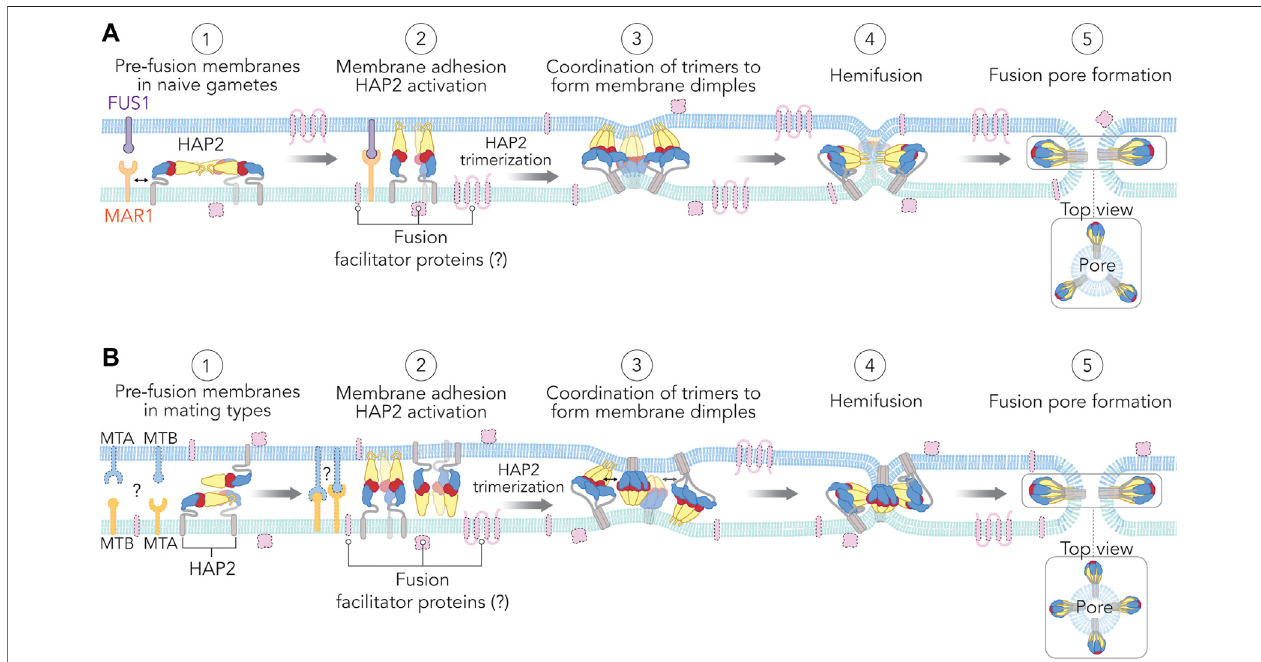
FIGURE 4 | Model molecular mechanisms for the (A) Chlamydomonas and (B) Tetrahymena gamete membrane fusion reactions. (1) Before fusion, HAP2 is expressed on the Chlamydomonas minus gamete mating structure, and membranes at the developing conjugation junction of Tetrahymena in an as yet unknown pre- fusion state. Both species strongly upregulate HAP2 expression after mixing of different mating types. The cytoplasmic domains of some proteins are not shown. Also, otherconservedorspecies-speci fi cfusionfacilitatorproteins(pink)thathavenotyetbeenidenti fi edmayactivelyparticipateinthisprocess. (2) In Chlamydomonas, FUS1-MAR1 mediated membrane adhesion activates HAP2 out of its pre-fusion state on naive minus gametes, driving HAP2 fusion loop interactions with the plus gametemembraneandtrimerformation.In Tetrahymena themembraneadhesionproteinsareunknown,butitispossiblethatMTAandMTBproteinsareinvolvedinthis recognition event, and similarly activate HAP2. (3) During conformational changes, the fusion loops and transmembrane domains of HAP2 proteins anchored in both membranes helps pull the two lipid bilayers close together. A circular coordination of several HAP2 trimers undergoing such changes is expected to form dimples in the apposed membranes. Chlamydomonas HAP2 trimers bridge the two membranes with their fusion loops anchored in the target plus gamete membrane, whereas Tetrahymena , having HAP2 protein expressed and functional on the membranes of both mating types, could undergo a different coordination of HAP2 trimers that contributes to its fusion ef fi ciency. (4) As HAP2 conformational changes continue to fold domain III (blue) back against the domain II (yellow) the two membranes are pulled evenclosertogether,helpingtoinitiatehemifusion,alipidmixingeventbetweentheouterlea fl etsofthetwobilayers. (5) CompletionofHAP2trimerizationinduces fullmixingofbothlea fl etsofthelipidbilayerandcreatesmembranefusionporewithstablepost-fusionHAP2homotrimersfastenedinthefusedmembranebytheirfusion loops and transmembrane domains. In this model, for simplicity the fusion pore is encircled by three or four trimers in a top-down view, but in reality,it is not known how many HAP2 trimers are necessary for fusion pore formation in any